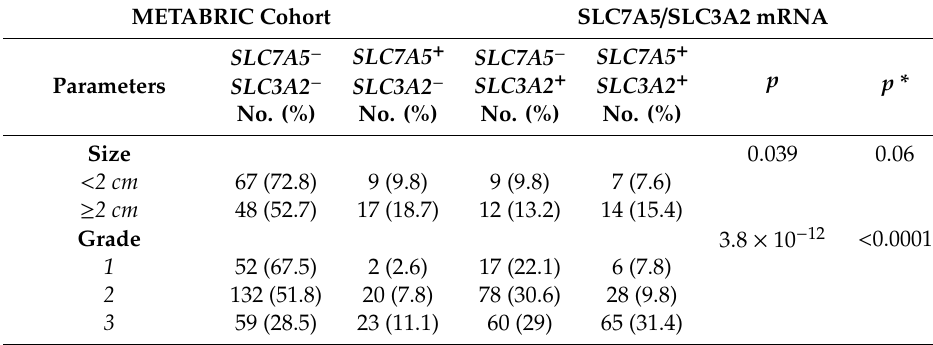
Table1. ClinicopathologicalassociationsofSLC7A5 / SLC3A2co-expressioninER +/ HER2 − breastcancer. METABRIC